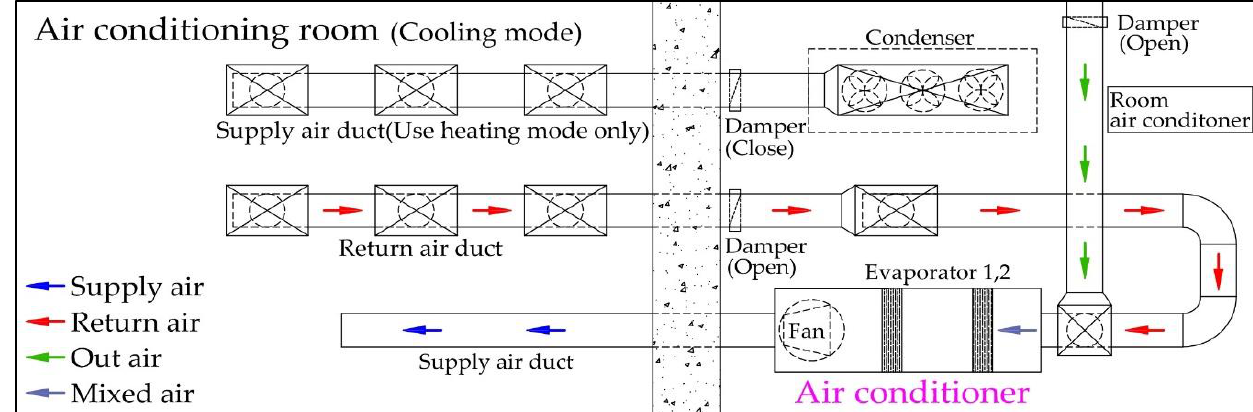
Figure 7. Air conditioning simulator layout .